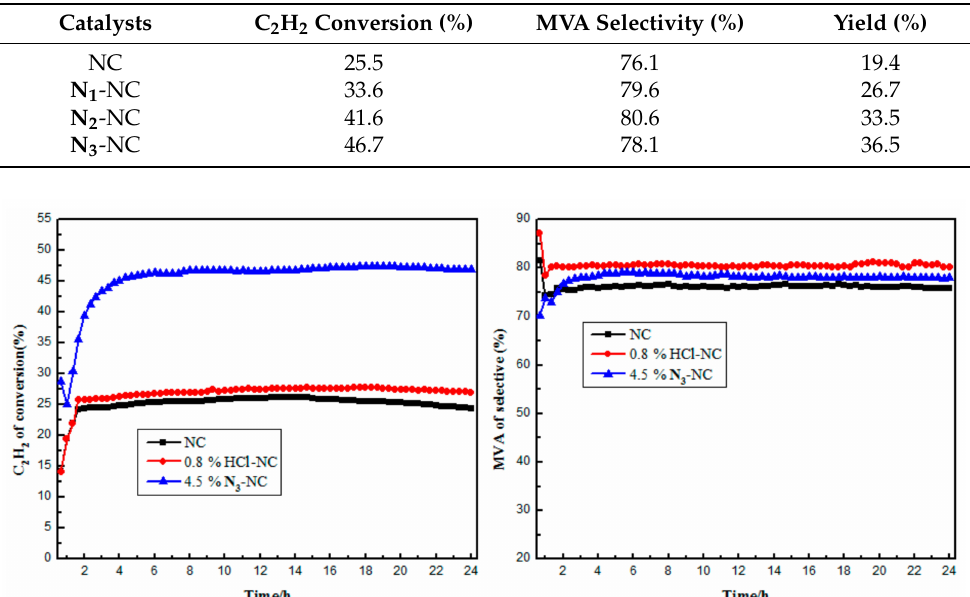
Table 1. Effect of NC and N -NC on acetylene conversion and MVA selectivity in acetylene dimerization.